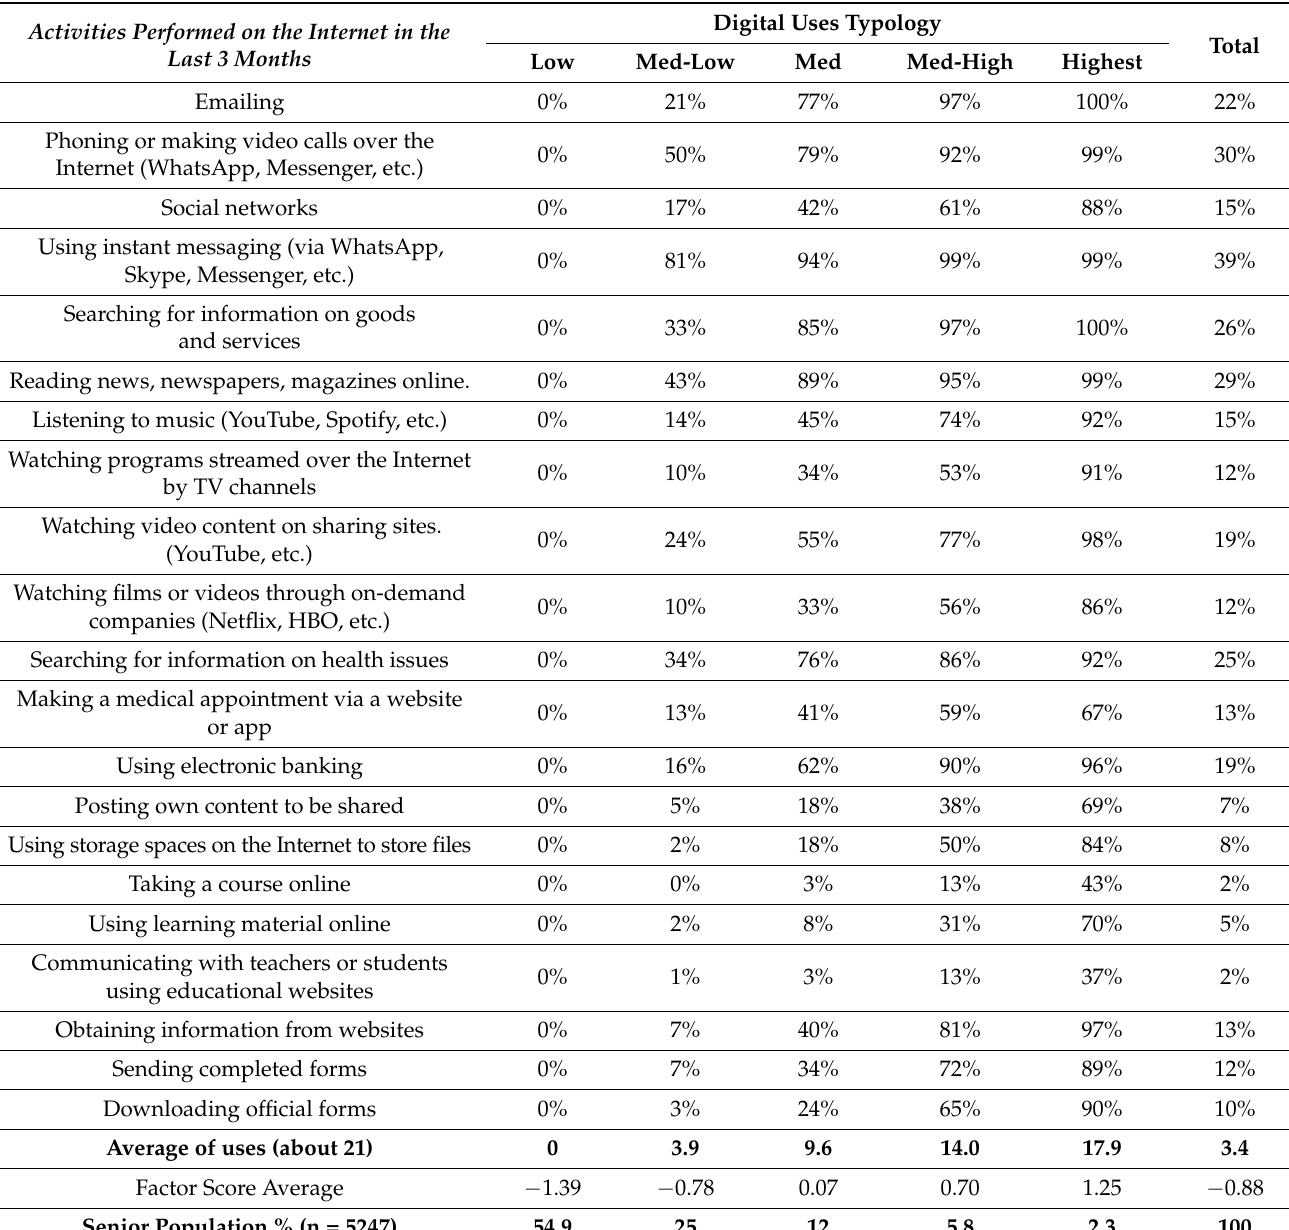
Table 4. Items comprising the digital uses